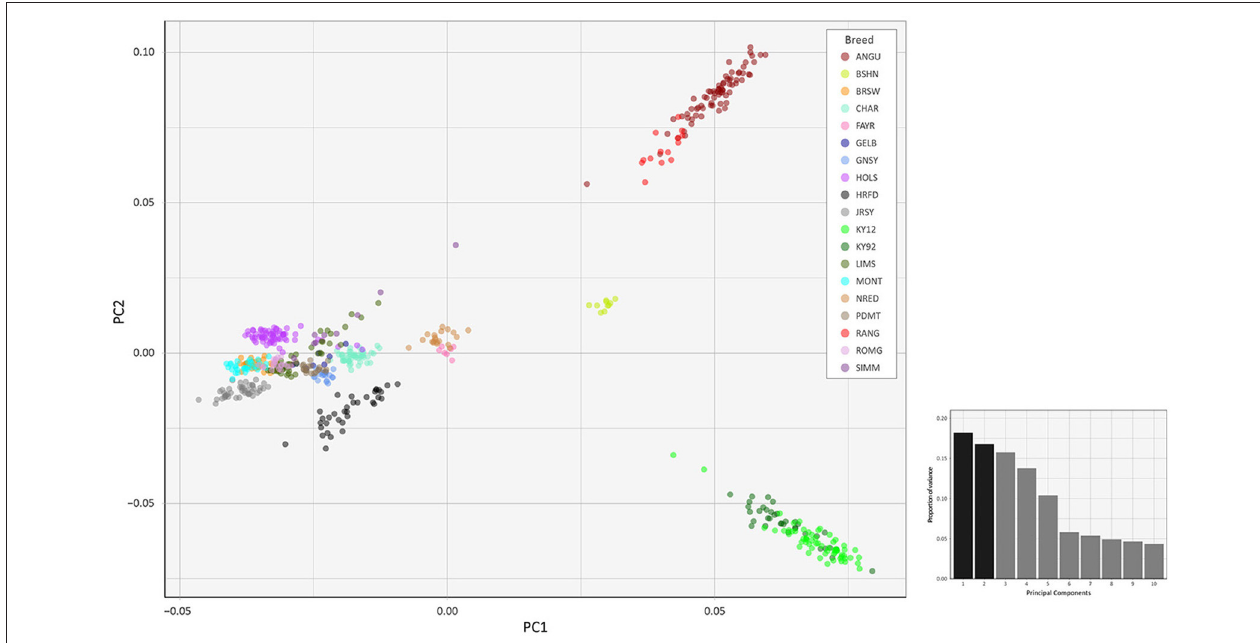
FIGURE 4 | Principal component analysis plot constructed for PC1 and PC2 from genome-wide SNP data (36,621 autosomal SNPs) for the EU data set of 605 individual animals. The smaller histogram plot shows the relative variance contributions for the first 10 PCs and PC1 and PC2 account for 18.2% and 16.8% of the total variation for PC1–10,